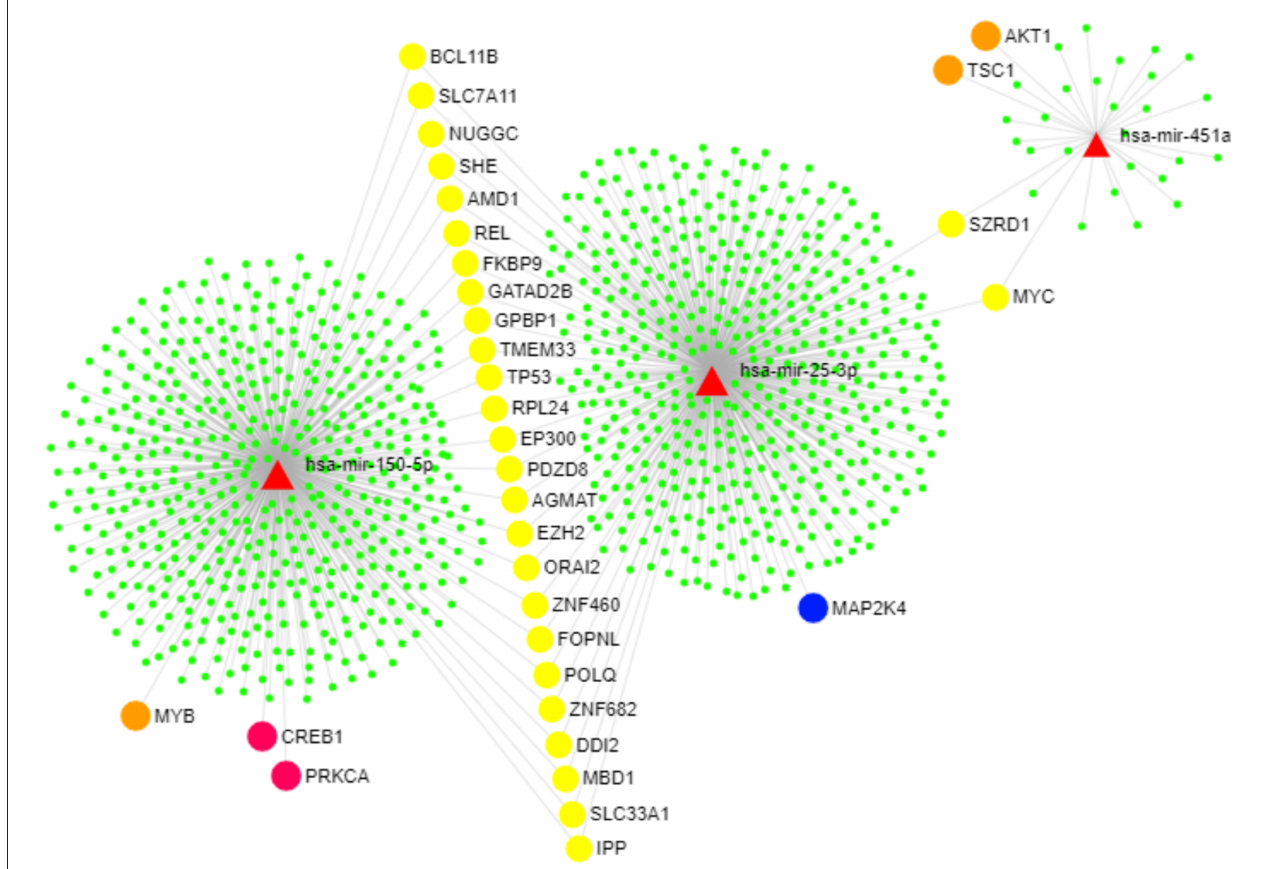
FIGURE 4 | miRNA-target gene network. Genes that modulate the PI3K-AKT and MAPK pathways are highlighted. This figure was generated using the miRNet 2.0 tool (45). The red triangles represent the three upregulated miRNAs (miR-150-5p, miR-25-3p, and miR-451a). The circles represent genes targeted by the identified miRNAs as follows: Orange circles represent genes in the PI3K-AKT pathway, the blue circle represents one gene included in the MAPK pathway, pink circles show genes that participate in both PI3K-AKT and MAPK pathways, yellow circles show genes that are commonly targeted by all of the identified miRNAs, and green circles show other miRNA target genes that participate in other